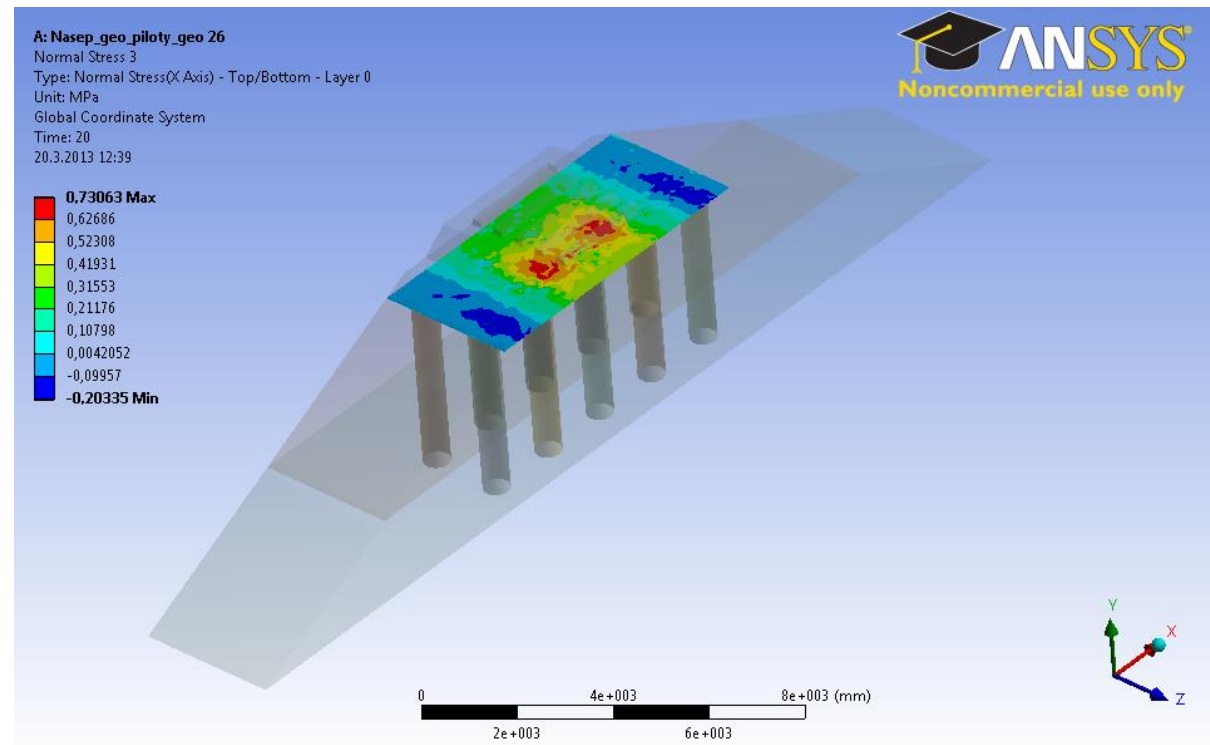
Figure 13. Stress field σ of the geogrid of the embankment reinforced by the geogrid and the columns sheathed a x geogrid.